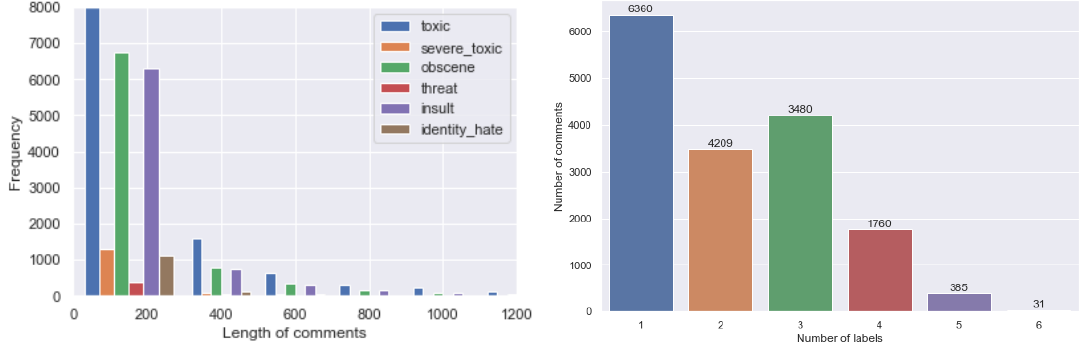
Figure 5. The first graph depicts the length of the comments in respective categories. The second one depicts the number of the comments belonging with multiple categories.